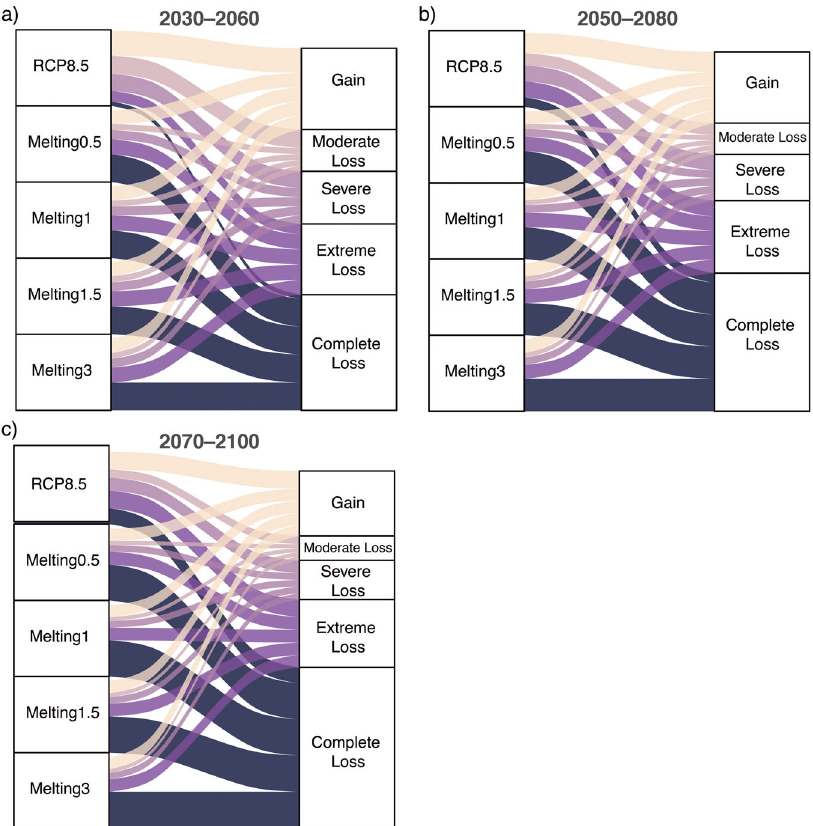
Fig. 5 Proportion of species falling within different categories of change in species ’ range sizes under different climate change scenarios. a – c Alluvial plots showing the distribution of fi ve categories of change in species ’ range size under the RCP 8.5 and the four melting scenarios. The vertical size of the blocks and the width of the fl ows are proportional to the frequency of species within each block/ fl ow. All scenarios have the same block size corresponding to the 21,146 modeled species. The fl ows represent the proportion of species within any of the fi ve categories (each of which has a color) as estimated under each of the fi ve scenarios. Range size estimation was based on species distribution models and was standardized relative to the present-day species range